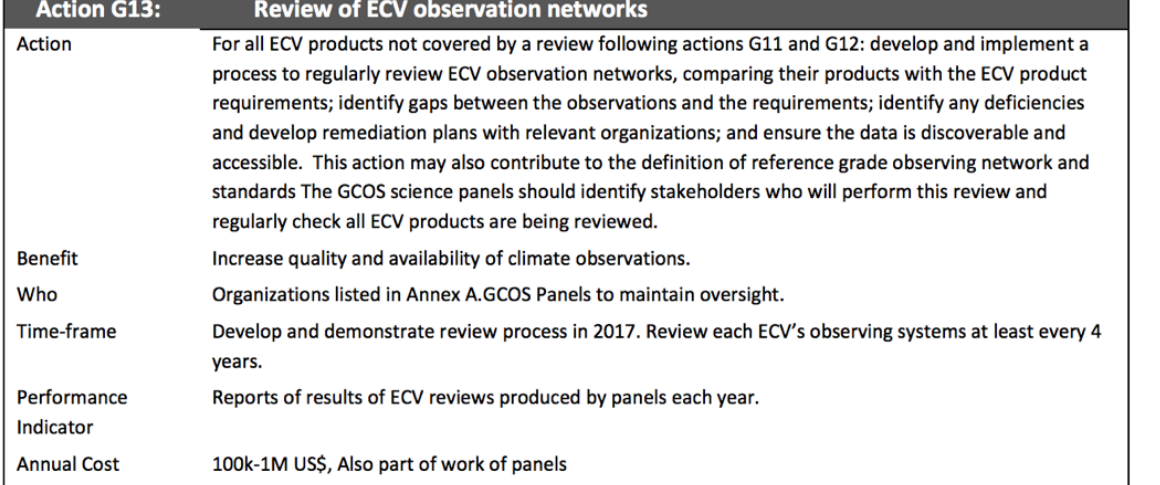
Figure 8. Action G13 of the GCOS Implementation Plan (GCOS, 2016) adopted by UNFCCC, which alludes to a capabilities based assess- ment of measurement assets which the present work may contribute